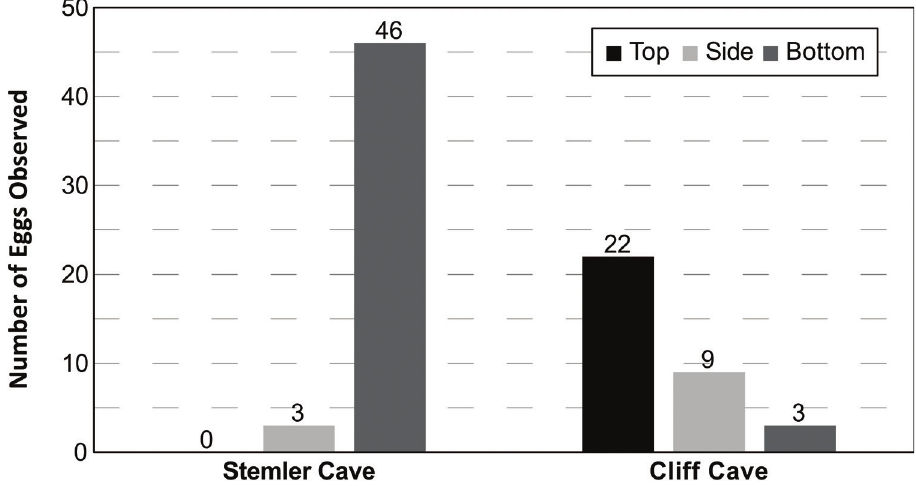
Figure 5. Comparison of egg deposition on top, side, and bottom surface of cobbles in captive Fontigens antroecetes from Stemler Cave, IL and Cliff Cave, MO under simulated cave